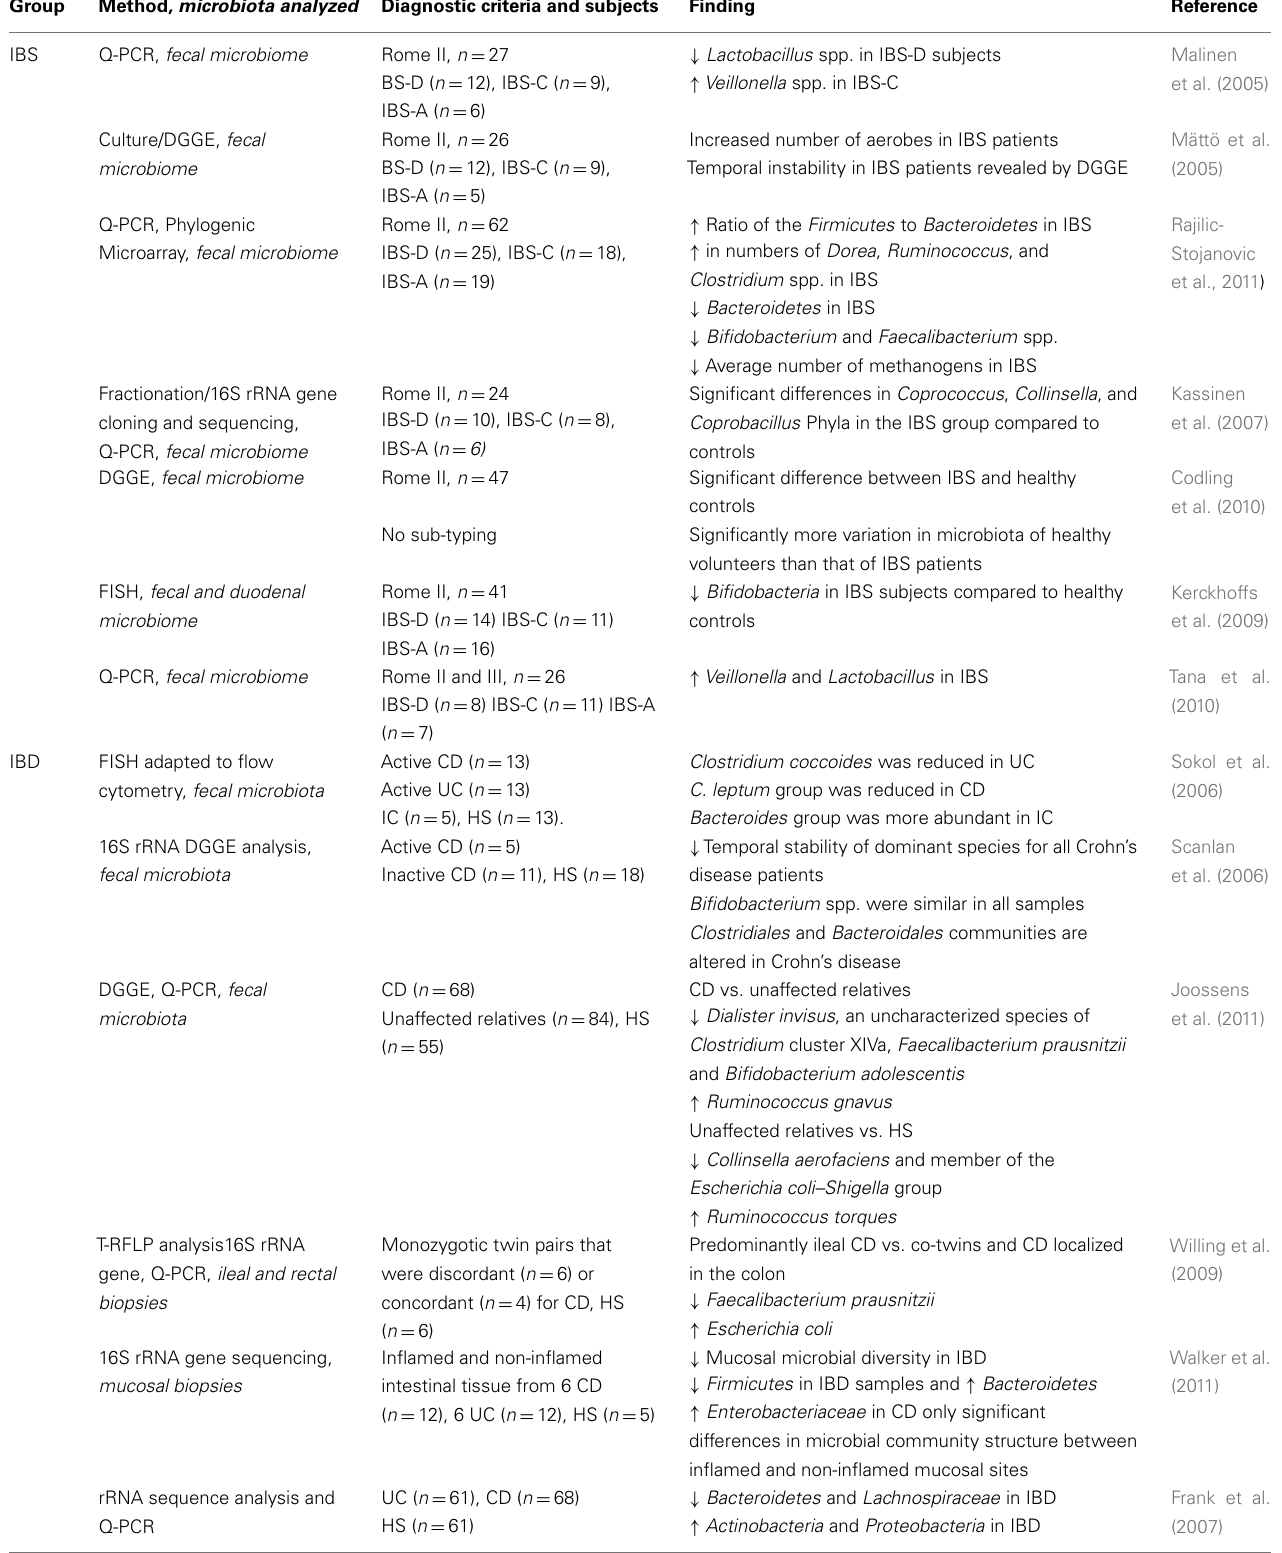
Table 1 | Studies which have shown altered fecal and mucosal microbiome in disease